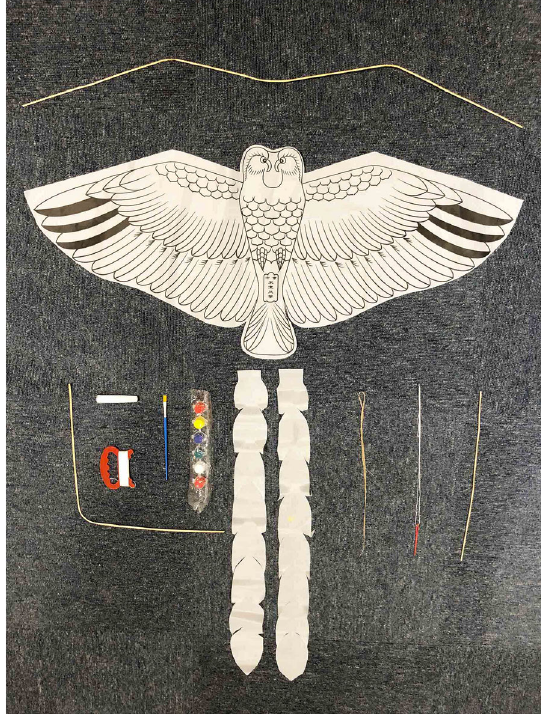
Fig. 7 Kite kits used for teaching (authors ’ photo,